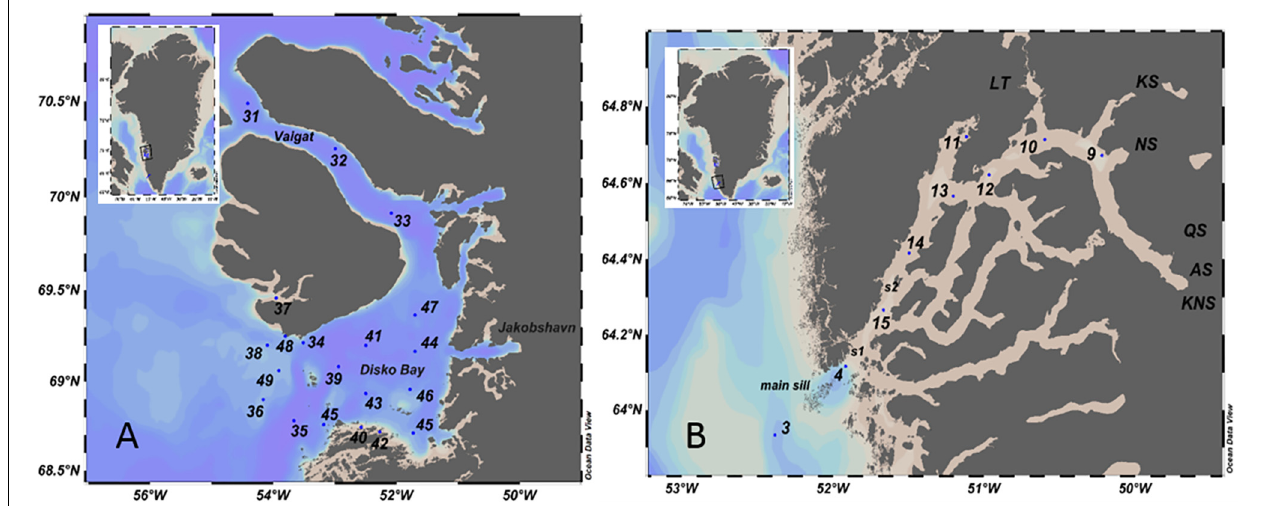
FIGURE 1 | Area of study. Vaigat-Disko Bay (A) and Godthabsfjord (B) , along southwest coast of Greenland. Summer campaign from June 26, 2017 to July 17, 2017 onboard research vessel Maria S. Merian (cruise ID MSM65). Numbers indicate sampled stations. Acronyms in panel (B) refer to marine terminating (KNS, Kangiata Nunata Sermia; AS, Akugdlerssup sermia; and NS, Narssap Sermia) and land terminating glaciers (QS, Qamanarssup Sermia; KS, Kangilinguata Sermia; and SS, Saqqap Semersua) in contact with the inner part of the